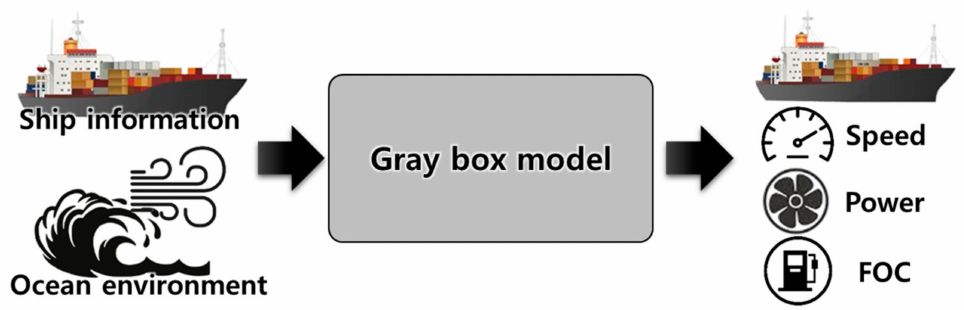
Figure 8. Input and output of the gray box model.FOC, fuel oil